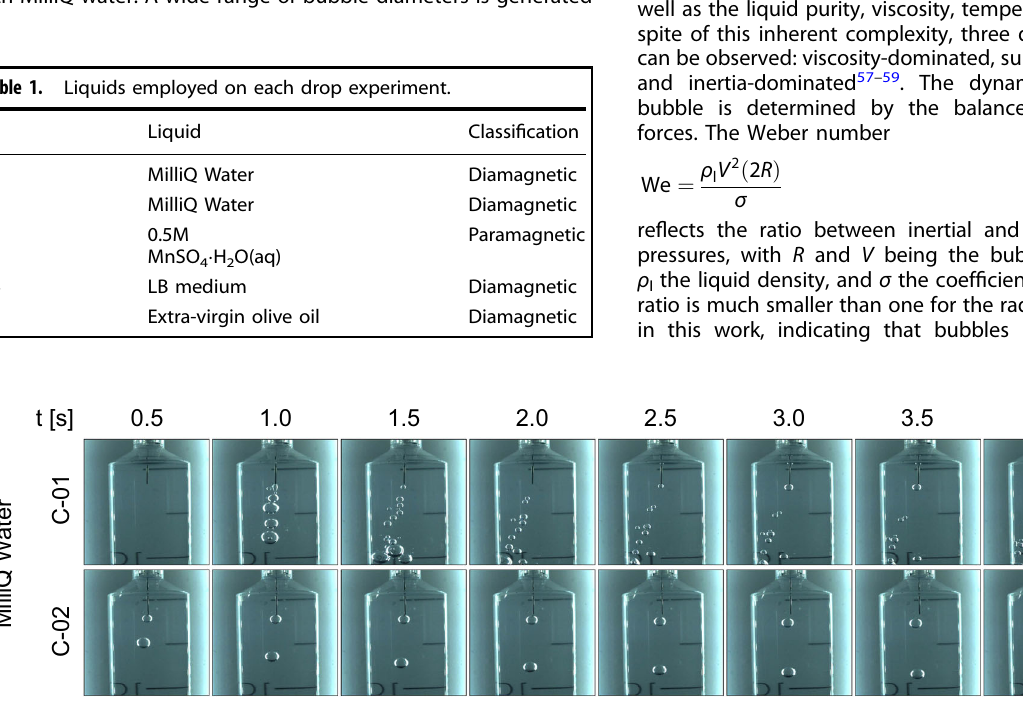
Fig. 1 Non-magnetic control (C) experiments for MilliQ water in microgravity. The injection and displacement of air bubbles are shown as a function of